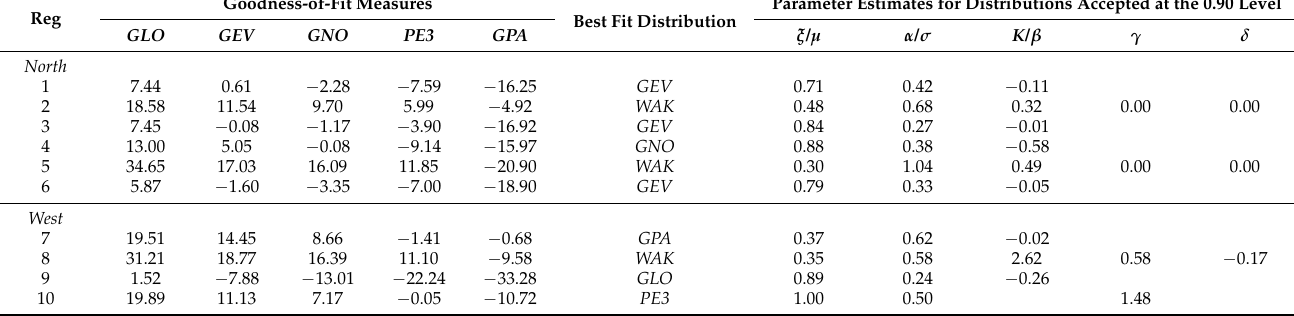
Table 2. GoF measures (Z-test), best fit Distribution, and parameter distribution of 22 homogenous Sub-Regions in